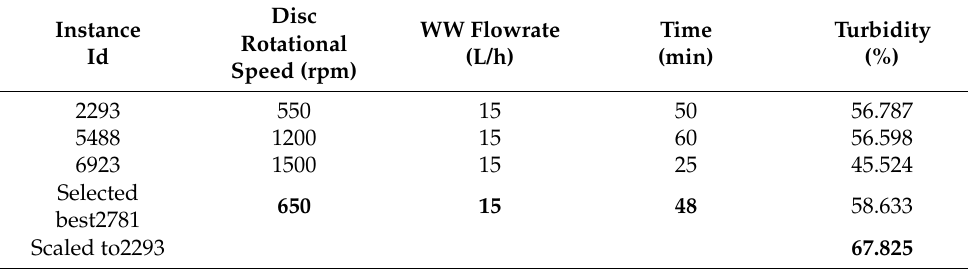
Table 8. Best values obtained by Random